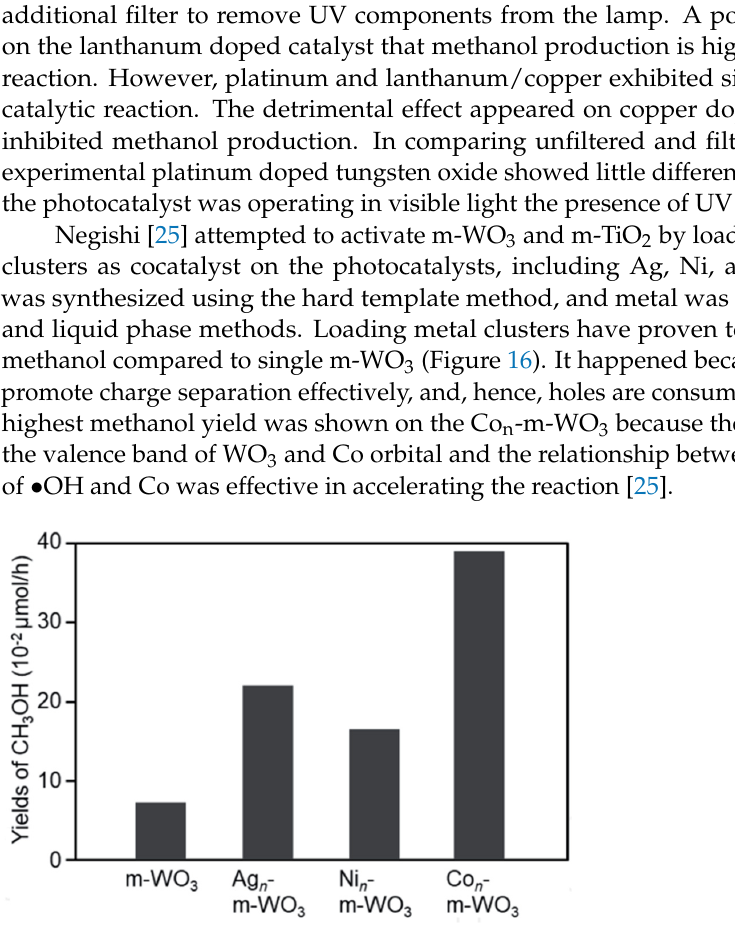
Figure 16. Methanol yield in several doped m-WO 3 [25]. Reproduced with permission from Negishi et al. Copyright © 2022 ASM Journals. et al. Copyright © 2022 ASM